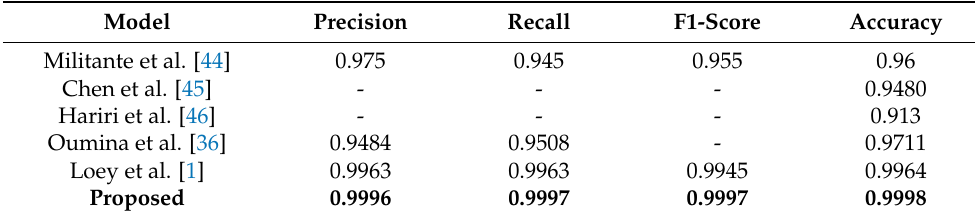
Table 7. A comparative analysis of the proposed model with other state-of-the-art